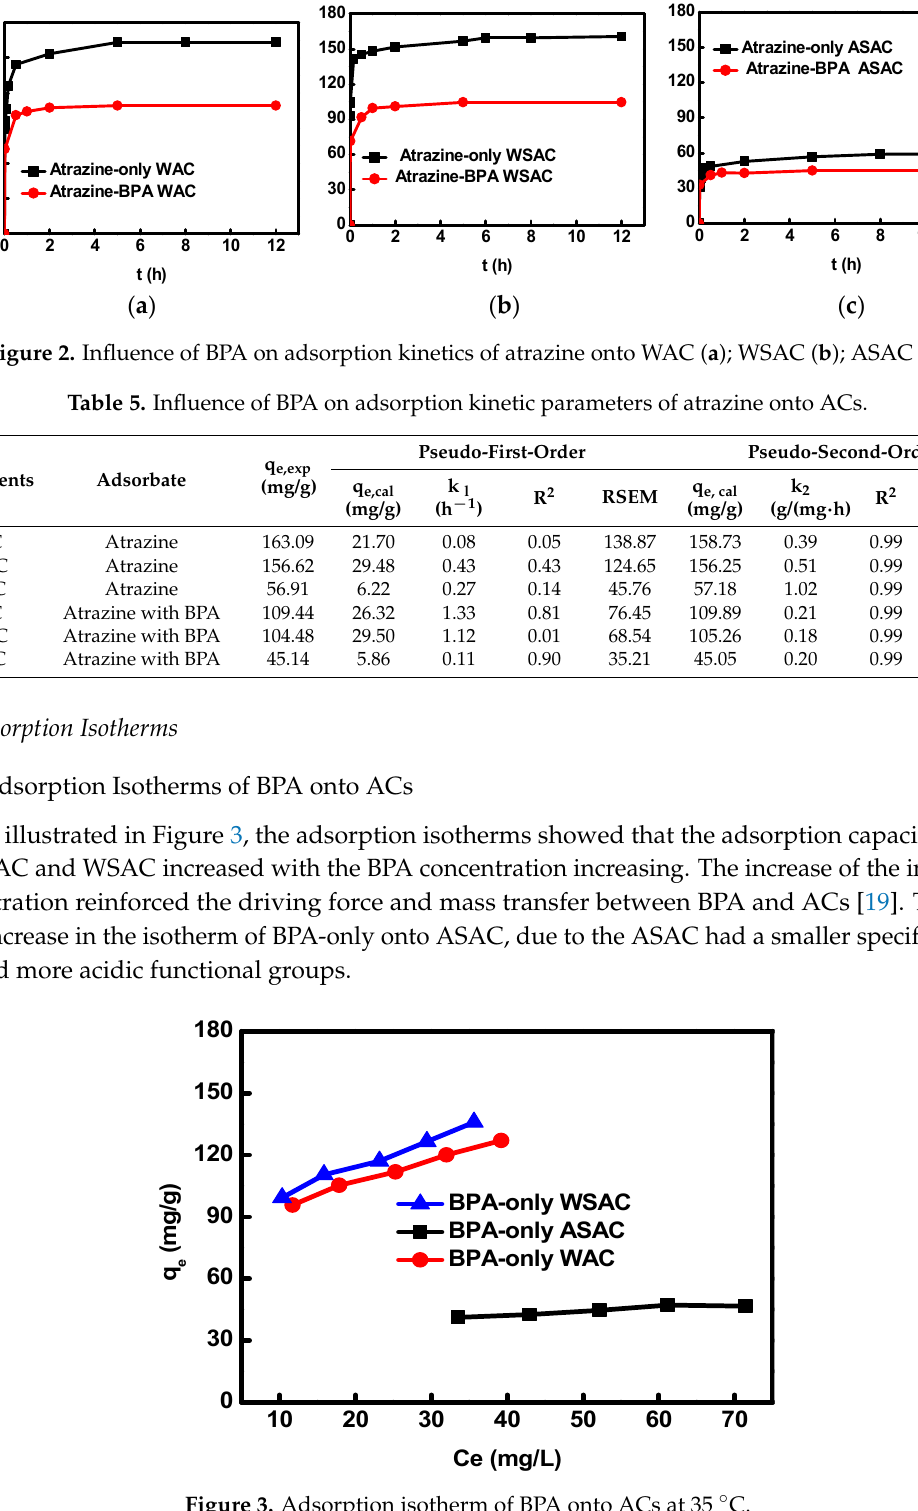
Figure 3. Adsorption isotherm of BPA onto ACs at 35 °C.